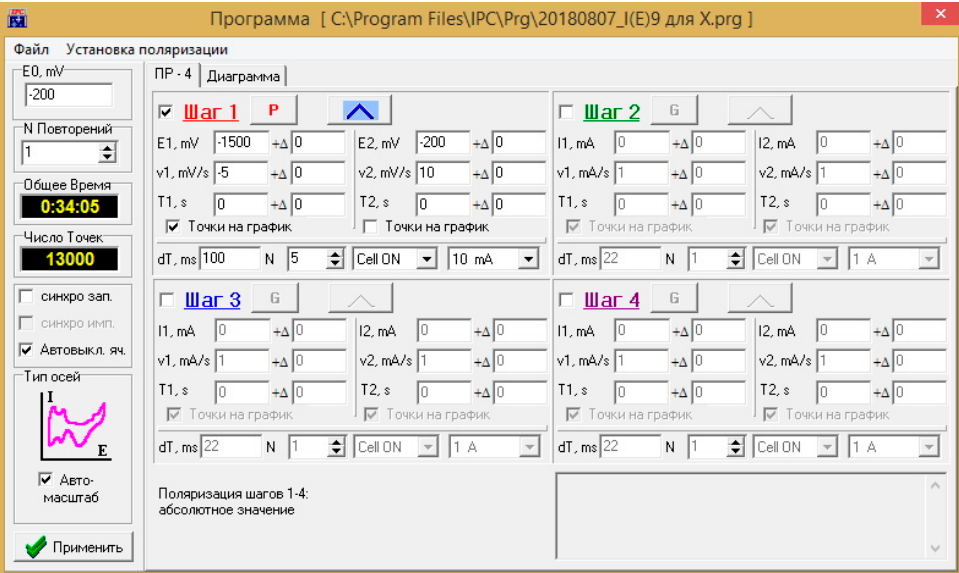
Figure 7. Program dialog box in IPC2000.